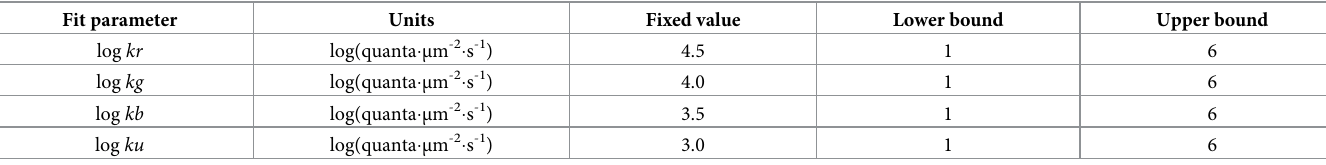
Table 5. Boundaries and seed values for cone fit parameters.